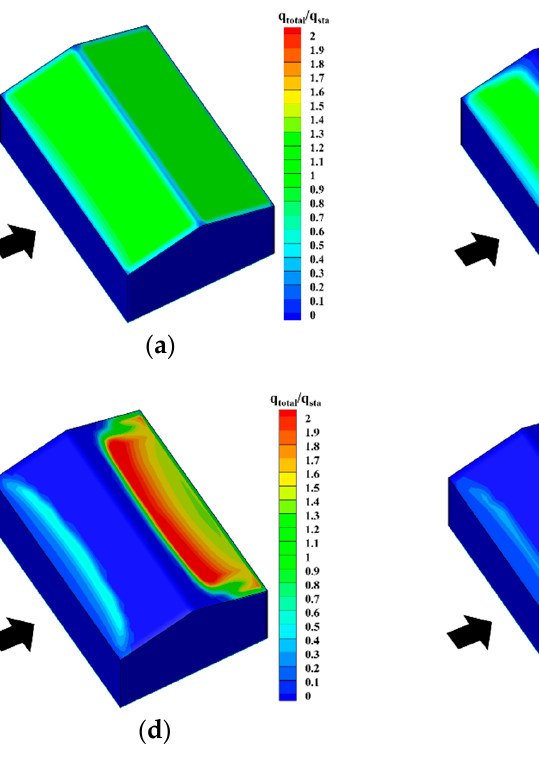
Figure 17. Normalized total deposition flux q total / q sta : ( a ) U H = 2 m/s; ( b ) U H = 3 m/s; ( c ) U H = 4 m/s; ( d ) U H = 5 m/s; ( e ) U H = 6 m/s; ( f ) U H = 7 m/s.